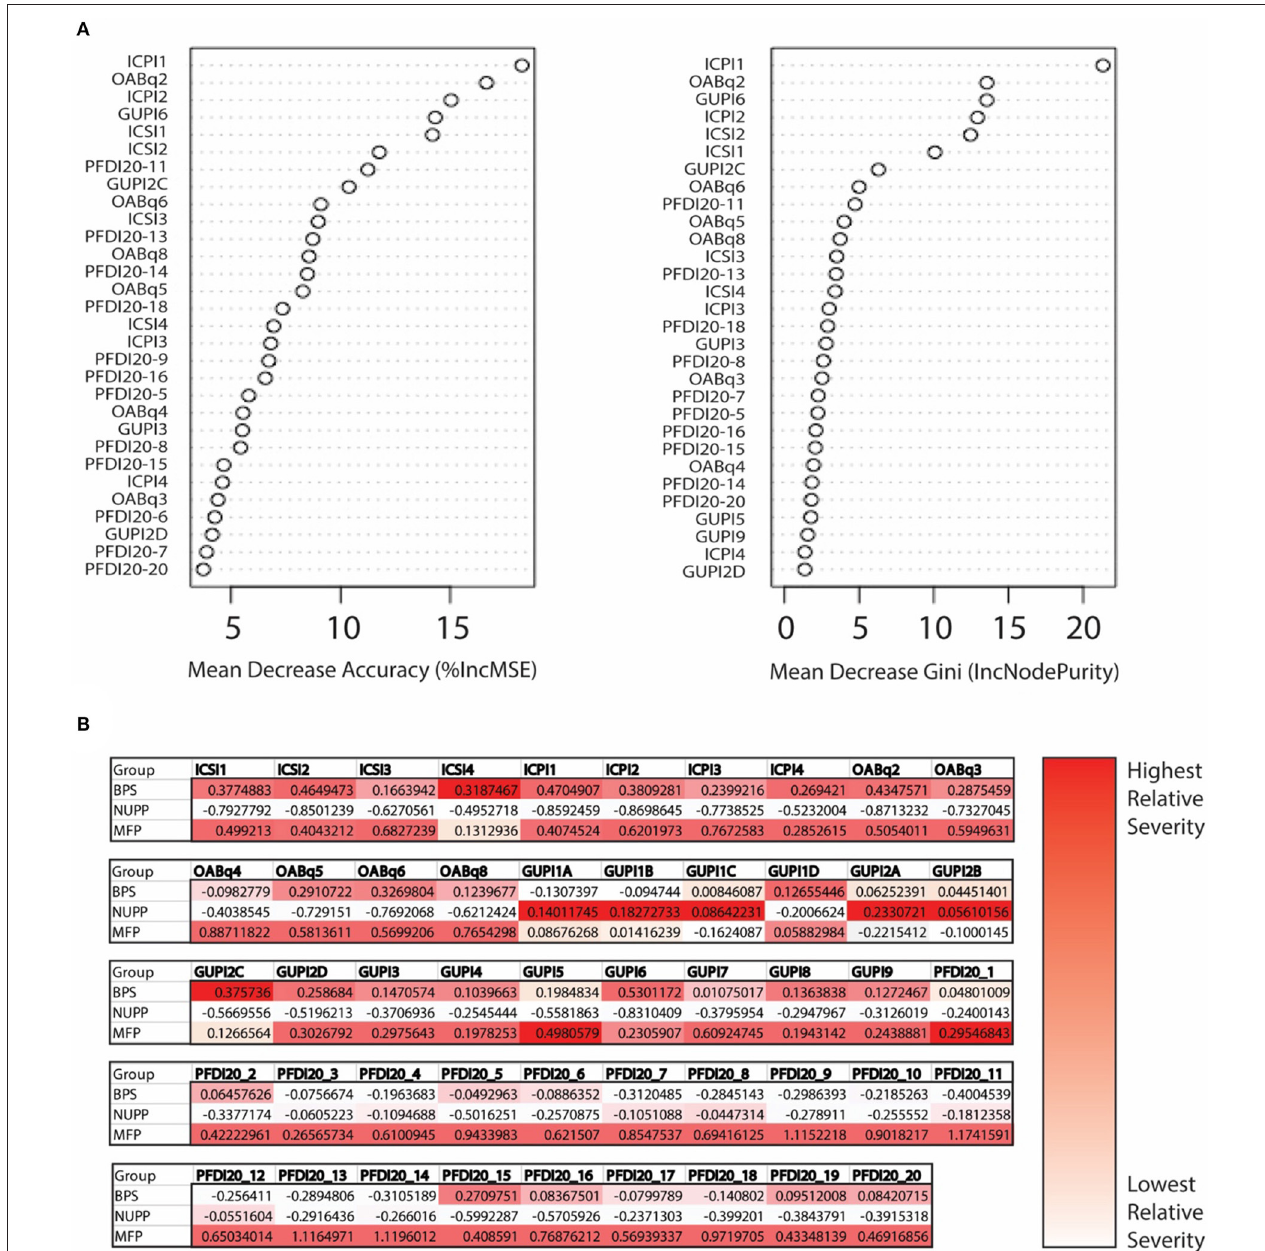
FIGURE 4 | Determination of important clinical features defining the unique IC/BPS phenotypes. (A) Variable importance plot demonstrating how important each variable is in classifying the data. Mean decrease Accuracy expresses how much accuracy the model loses by excluding individual variables. The mean decrease in Gini coefficient measures how much each variable contributes to generating homogeneous nodes, with higher values indicating greater importance in the model. (B) Mean scores for each phenotype are expressed as Z scores to provide a normalized distribution of scores relative to the mean of the overall population regardless of individual item scale. These were then expressed in heat maps for each question to provide a visual representation of scores uniquely associated with a single phenotype, with the highest scoring questions shown in the darkest red.